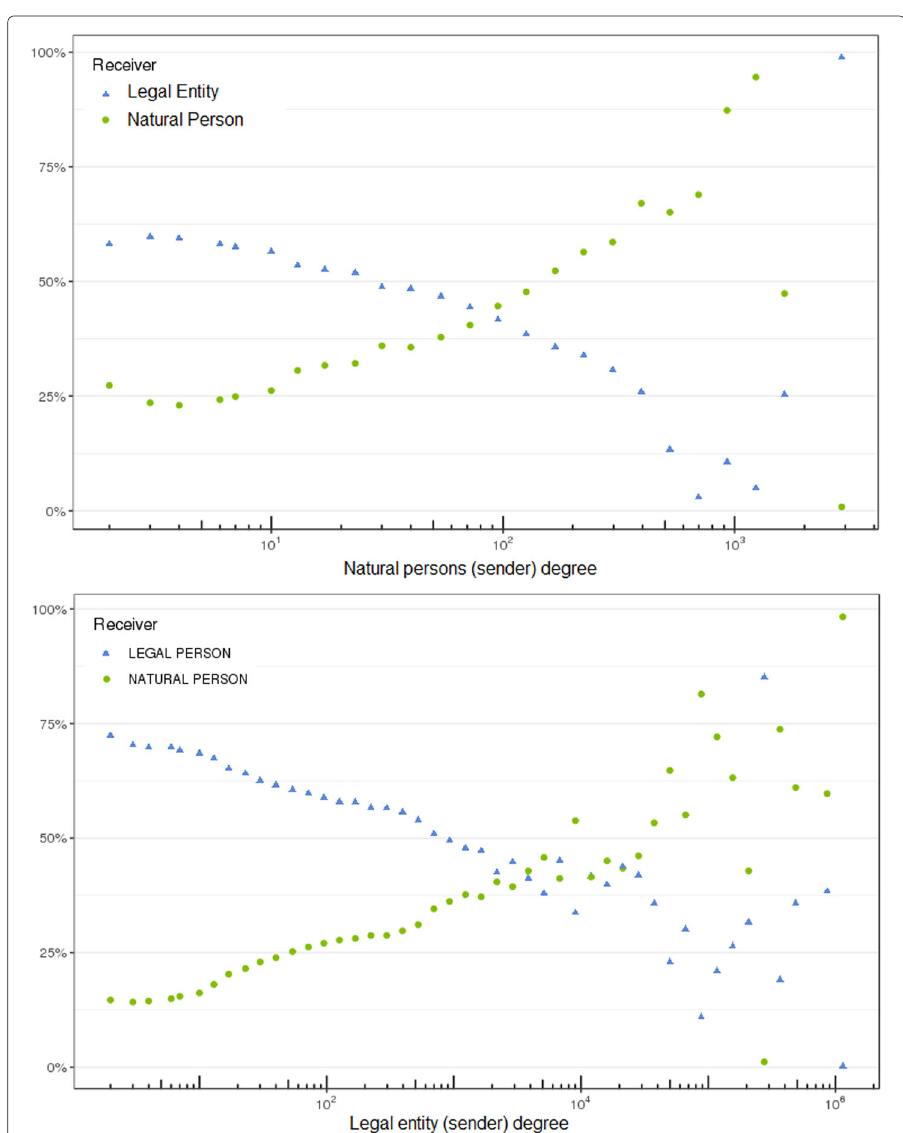
Fig. 14 Receiver type per sender type/degree in the SCC core: ratio of natural and legal receivers for natural (top) or legal (bottom) sender, according to their degree. Lower degree nodes tend to send money to